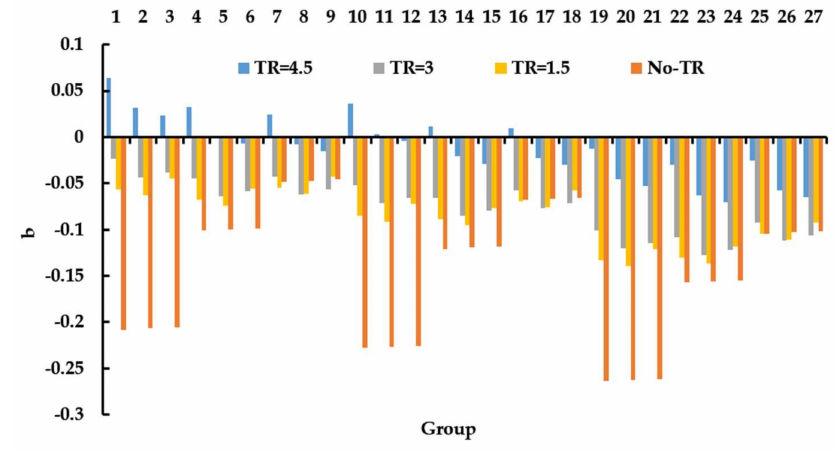
Figure 6. Comparison of the coefficient b of the two models.